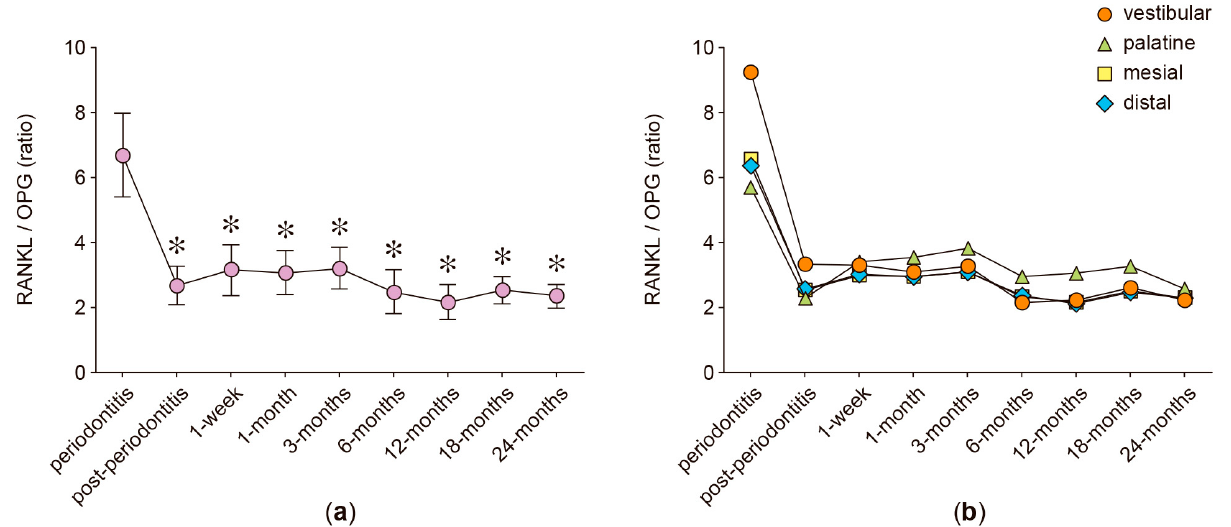
Figure 3. RANKL/OPG ratio. ( a ) RANKL/OPG ratio detected in the gingival crevicular fluid of periodontally compromised anterior teeth before periodontitis treatment (periodontitis), after periodontitis treatment (post-periodontitis), and during 2 years of patient-specific orthodontic treatment (1 week to 24 months), using intermittent low-intensity orthodontic forces. Data are represented as ratios and shown as mean ± SD. ( b ) RANKL/OPG ratio detected in each periodontal site, analyzed at the same time-points described in ( a ). * p < 0.05 periodontitis compared with post-periodontitis and all the time-points of orthodontic treatment.